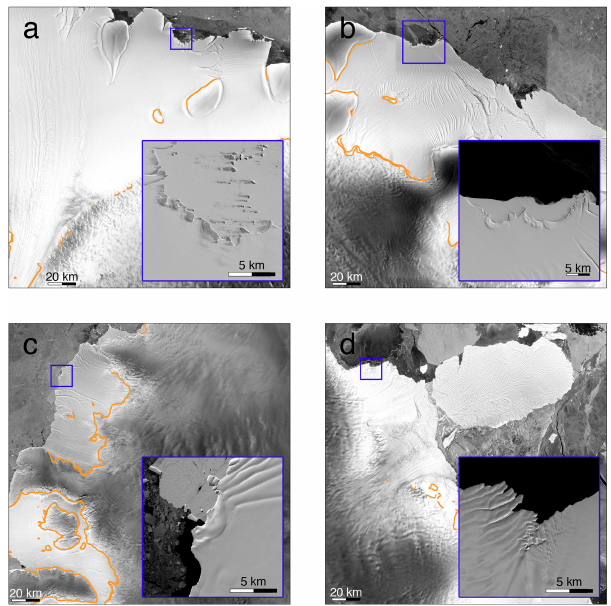
Figure 7. RAMP imagery for Fimbul (a) , Mushketov (b) , Ven- able (c) and West Ice Shelf (d) . Blue rectangles encircle the loca- tions of the identified PPPs (Table 2). Insets show closeups of these locations with satellite imagery from LIMA. Orange lines delineate multi-year grounding line positions by Rignot et al.